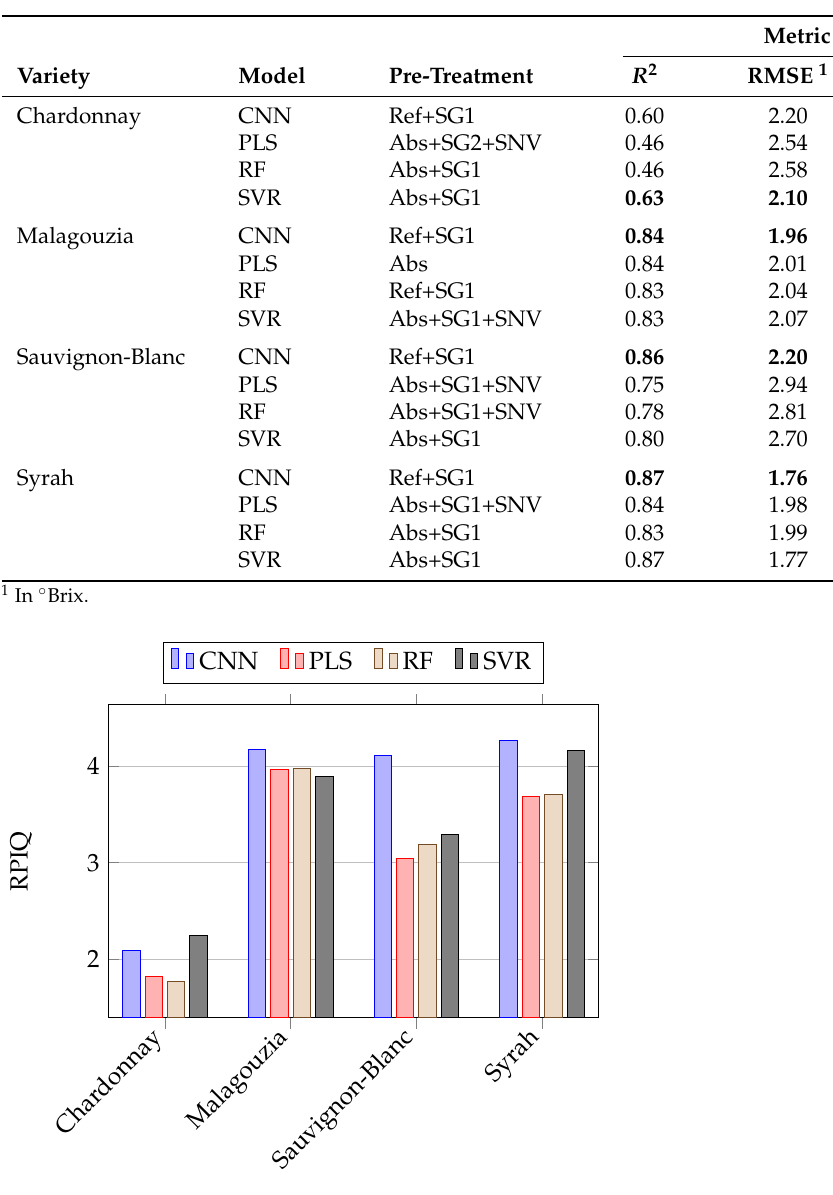
Table A1. Additionally provided in Figure 10 are the predictions of the CNN model using the Ref+SG1 spectra for the Syrah variety in the independent test set (i.e., the best model); the respective results of Table 3 are the mean metrics calculated across the five-folds. It is thus visible that there are some slight variations across the folds, which justifies our selection to use a five-fold cross-validation strategy to provide more robust comparisons. Table 3. Results of the mean prediction error metrics on the independent test set across the 5-folds, for each grape variety and all models examined; for all models, the table also indicates which spectral pre-treatment yielded the best results, while boldface denotes the best results for each variety.